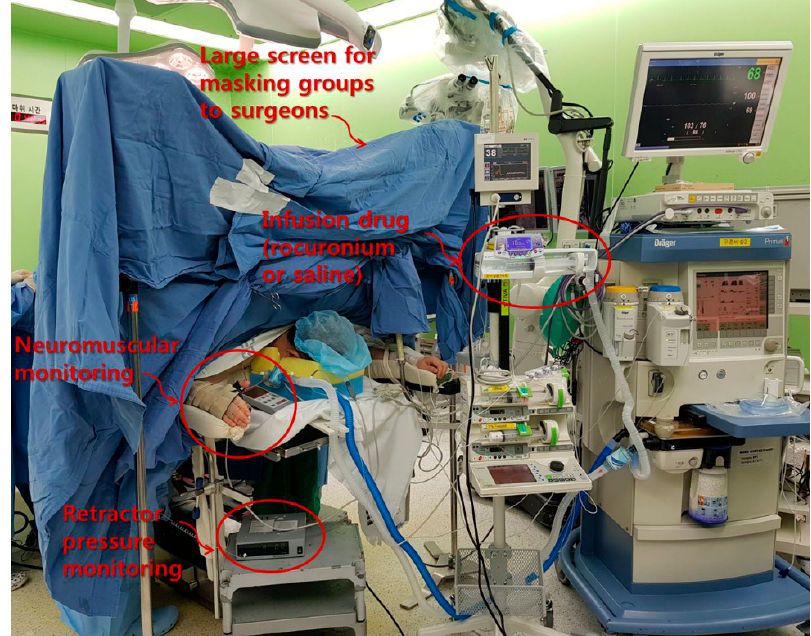
Figure A2. The patient positioning and the study setup including the screen setup for masking groups from surgeons.